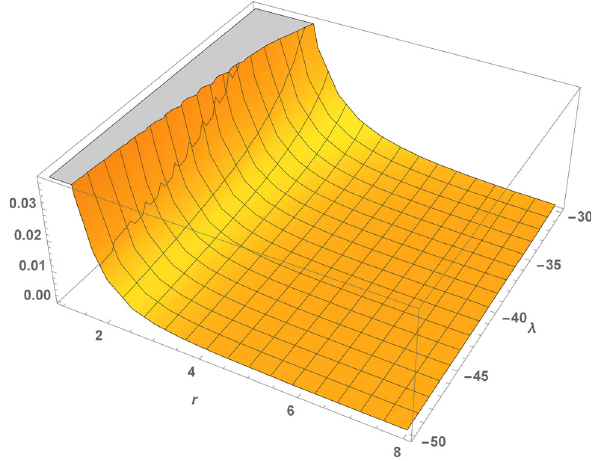
Fig. 13 Validation of SEC, ρ + p r + 2 p t ≥ 0, for α = 5 and different